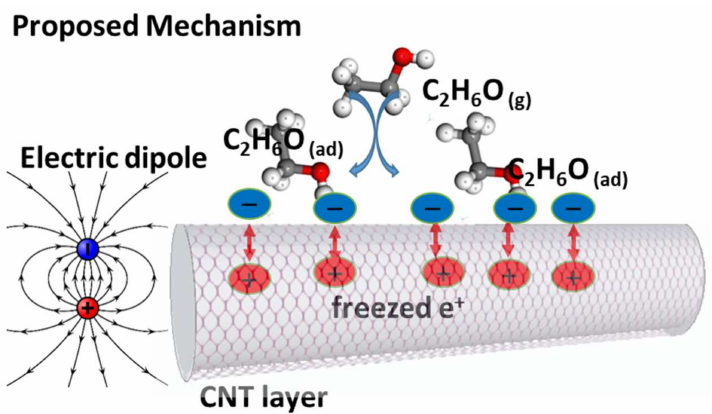
Figure 8. Proposed gas sensing mechanism based on Coulomb’s